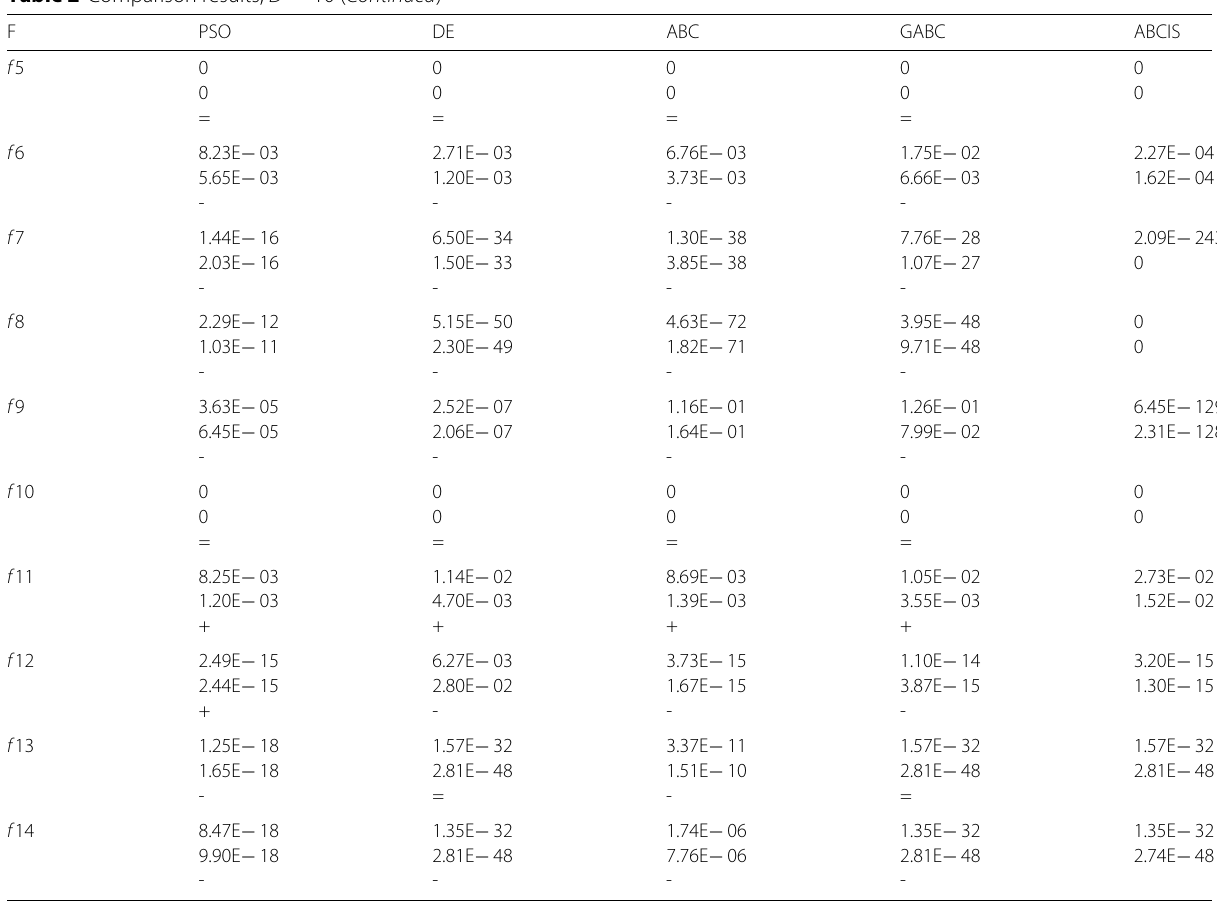
Table 2 Comparison results, D = 10 ( Continued )